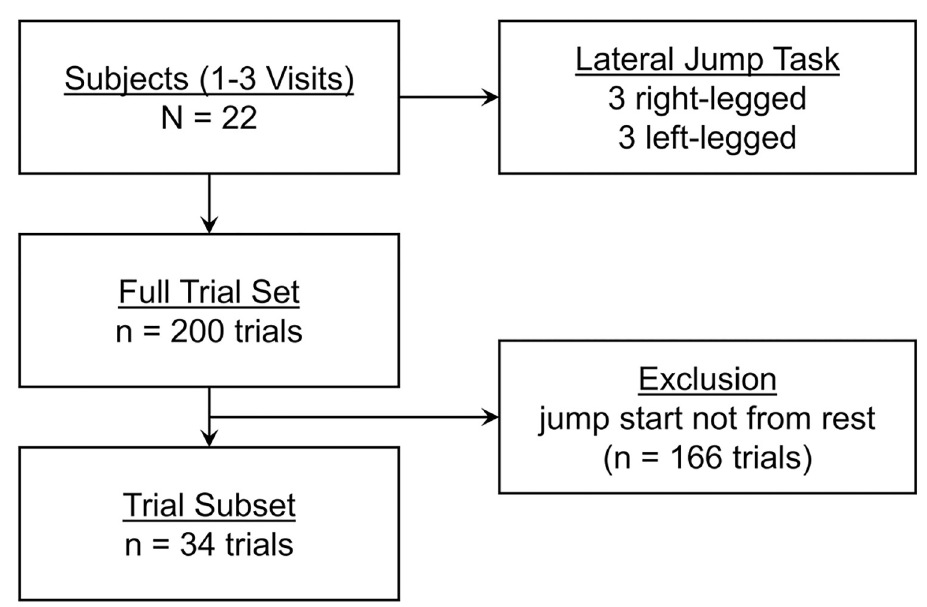
Fig 3. Flow chart of trial